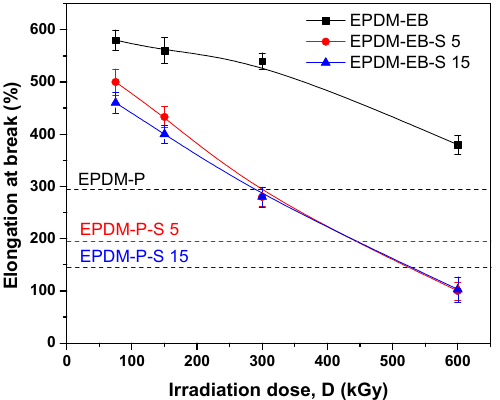
Figure 4. The influence of sawdust amount and cross-linking method (P / EB) on composites’ elongation at break.